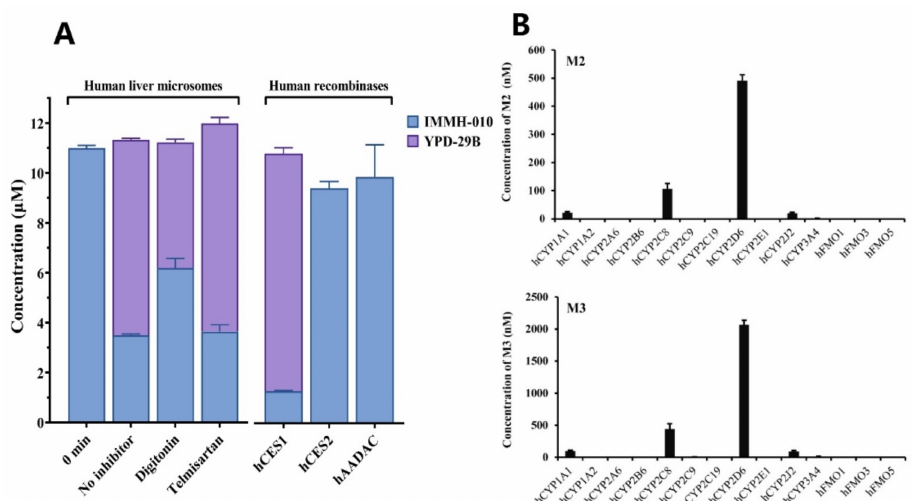
Figure 6. Effects of various human esterases, CYPs, and FMOs on IMMH-010 metabolism. ( A ), Effects of esterases on IMMH-010 metabolism. IMMH-010 (10 µ M) was incubated with HLM (0.2 mg/mL) for 15 min at 37 ◦ C in the presence of chemical inhibitors (left). The selective CES1 and CES2 inhibitors were digitonin (100 µ M) and telmisartan (50 µ M). IMMH-010 (10 µ M) was incubated individually with recombinant human CES1, CES2, and AADAC (0.1 mg protein/mL) at 37 ◦ C for 15 min (right). ( B ), Effects of CYPs and FMOs on IMMH-010 metabolism. IMMH-010 (10 µ M) was incubated individually with 50 pmol of recombinant human CYPs and FMOs at 37 ◦ C for 30 min in the presence of an NADPH regenerating system. Data are expressed as mean ±